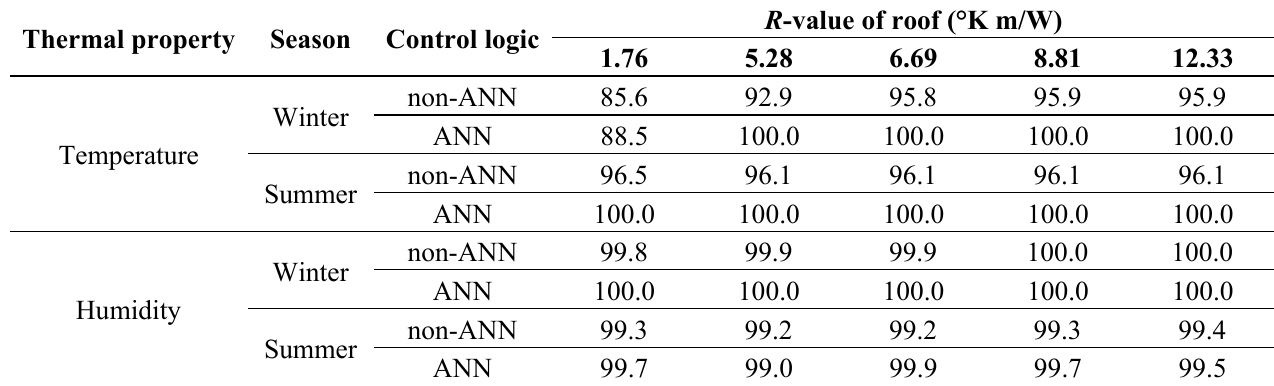
Table 6. Percentage of period within comfortable range according to R -value of roof (unit: %). Thermal